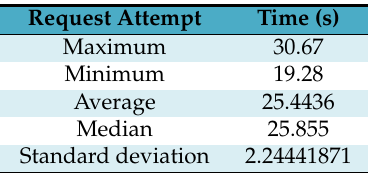
Table 8. Most prominent figures obtained from CDT discovery measures.